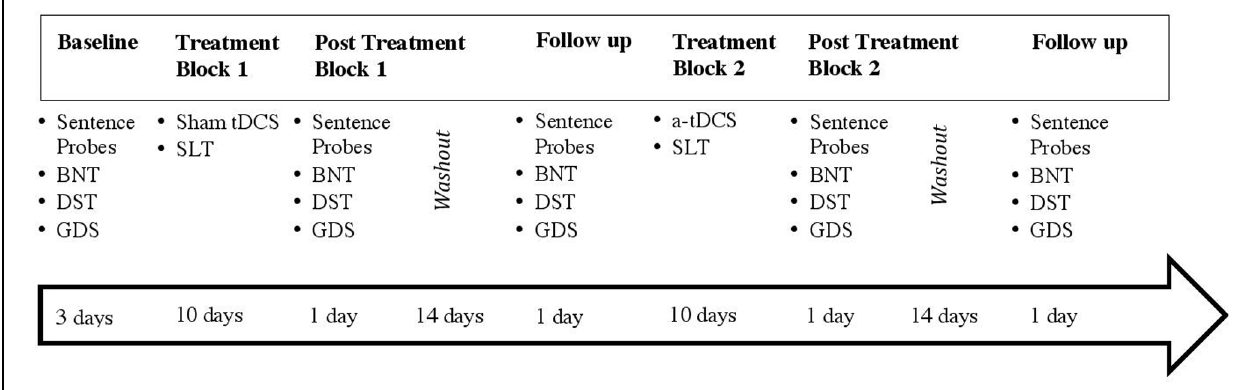
FIGURE 1 | Timeline and experimental design of the